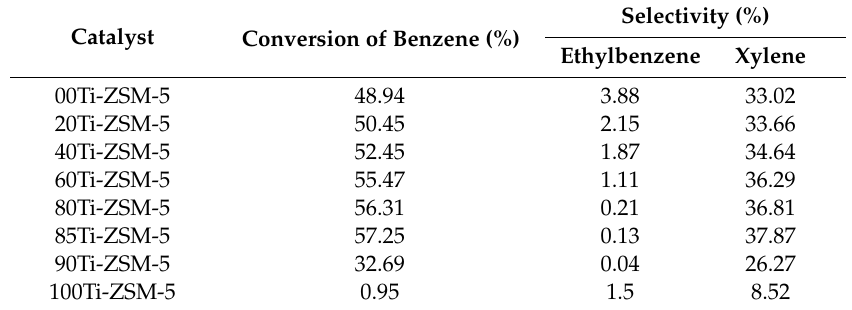
Table 3. Catalytic activity of hierarchical porous Ti-ZSM-5 samples in benzene alkylation with methanol. Catalyst Conversion of Benzene